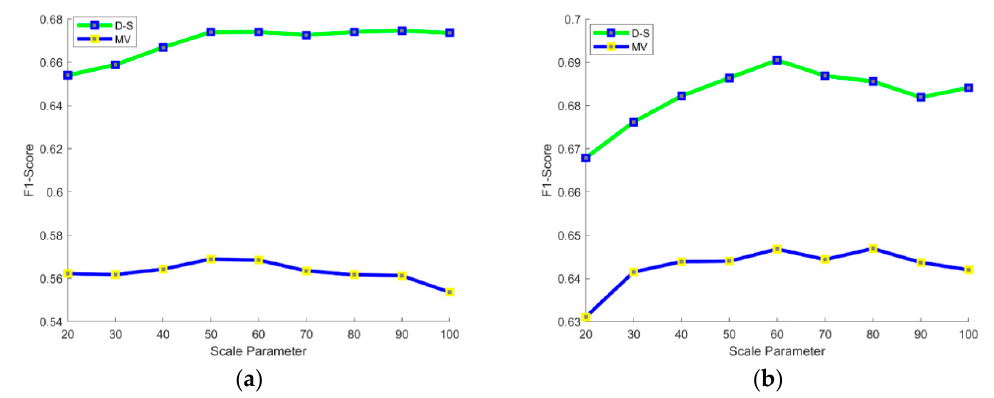
Figure 8. Sensitivity analysis of the scale parameter: ( a ) experiment 1 and ( b ) experiment 2.